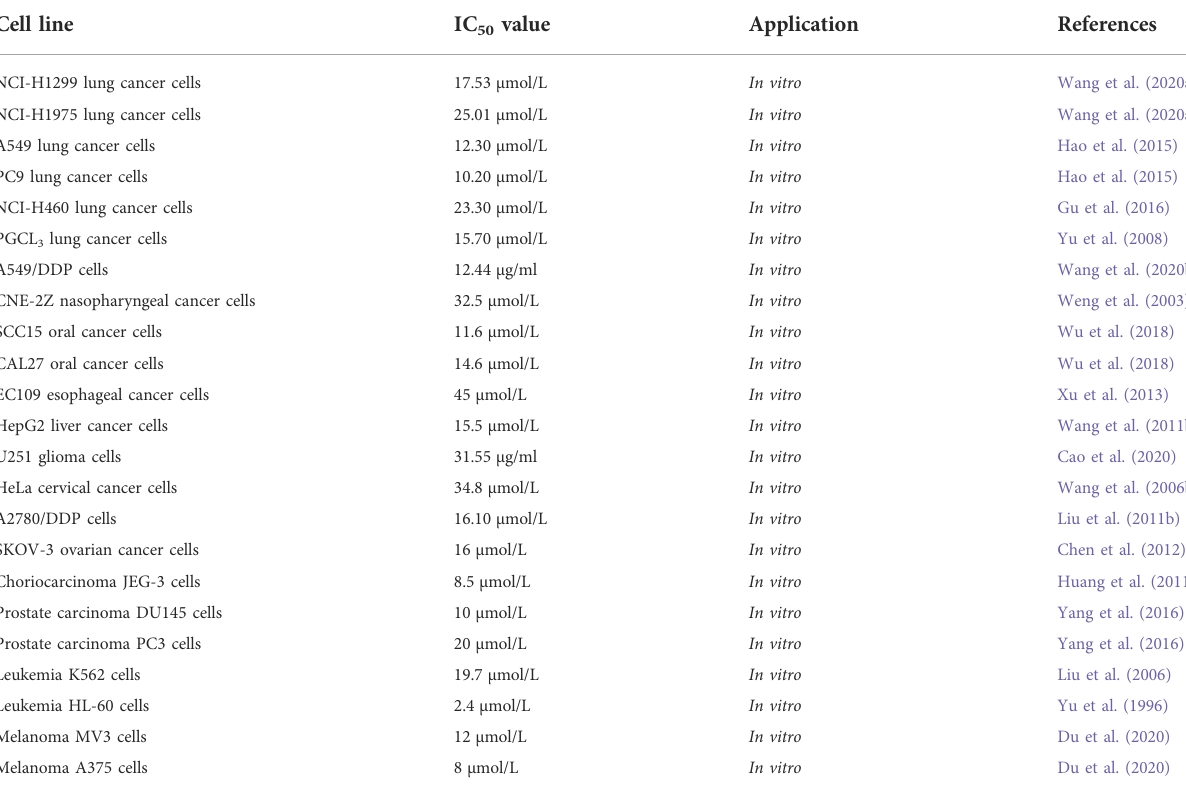
TABLE 3 The IC 50 value of TBMS-1 in various types of tumor